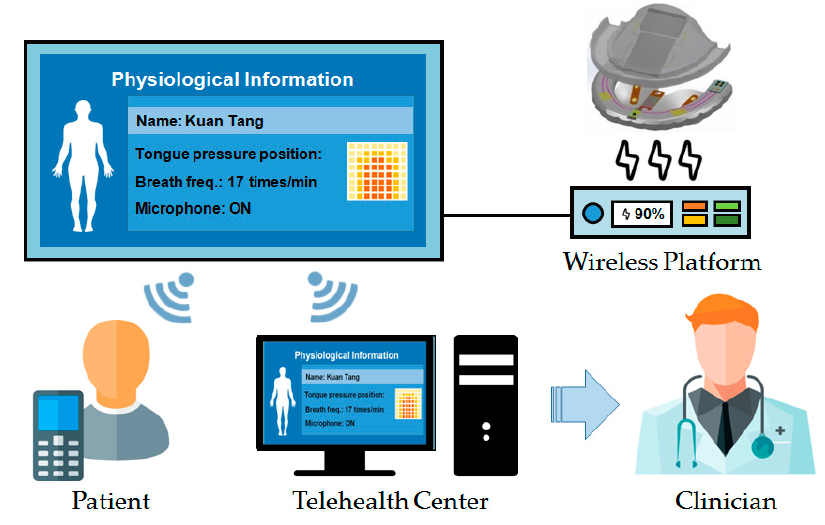
Figure 1. Application scenario of the proposed system.